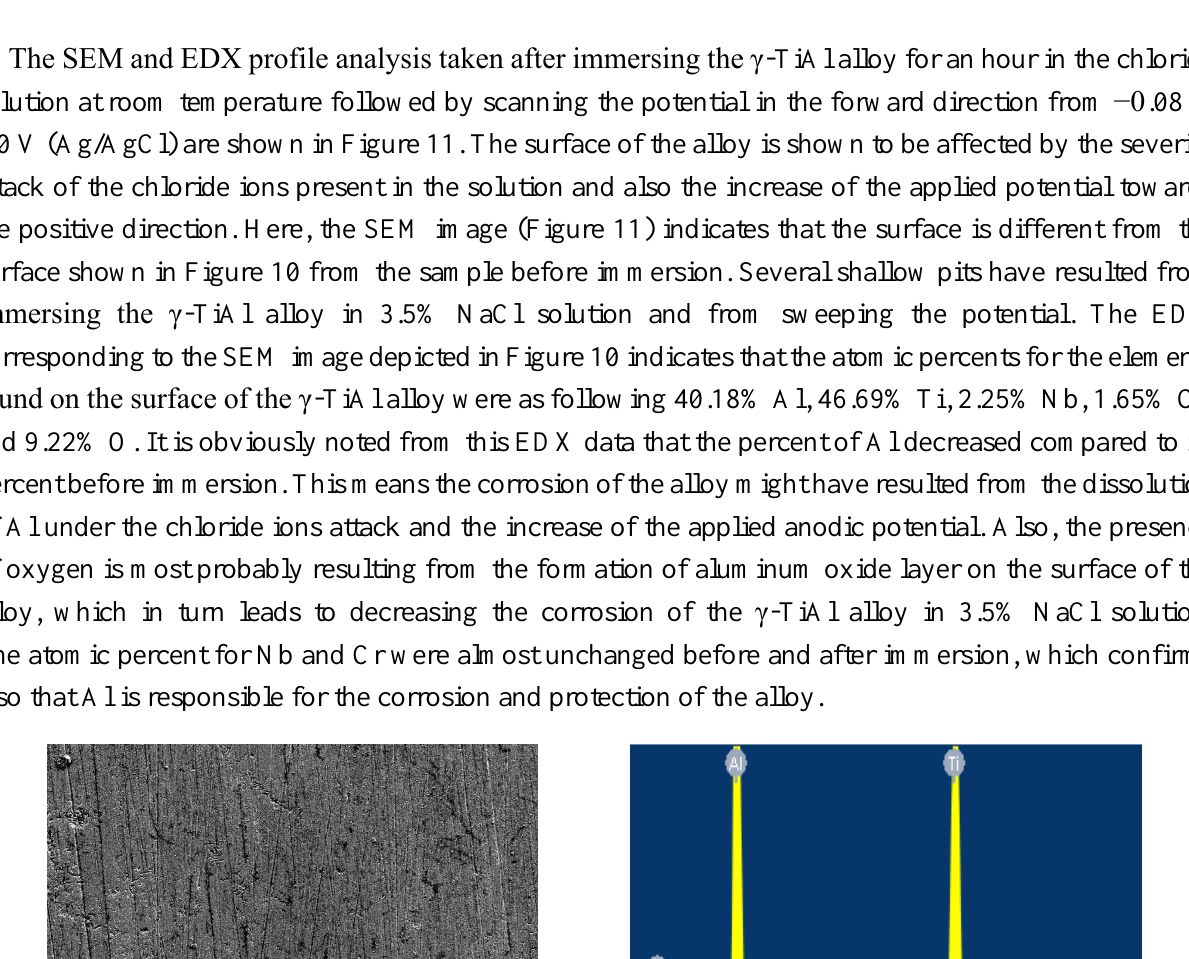
Figure 10. SEM micrograph and EDX profile analysis for the γ-TiAl alloy before its immersion in 3.5% NaCl solution.